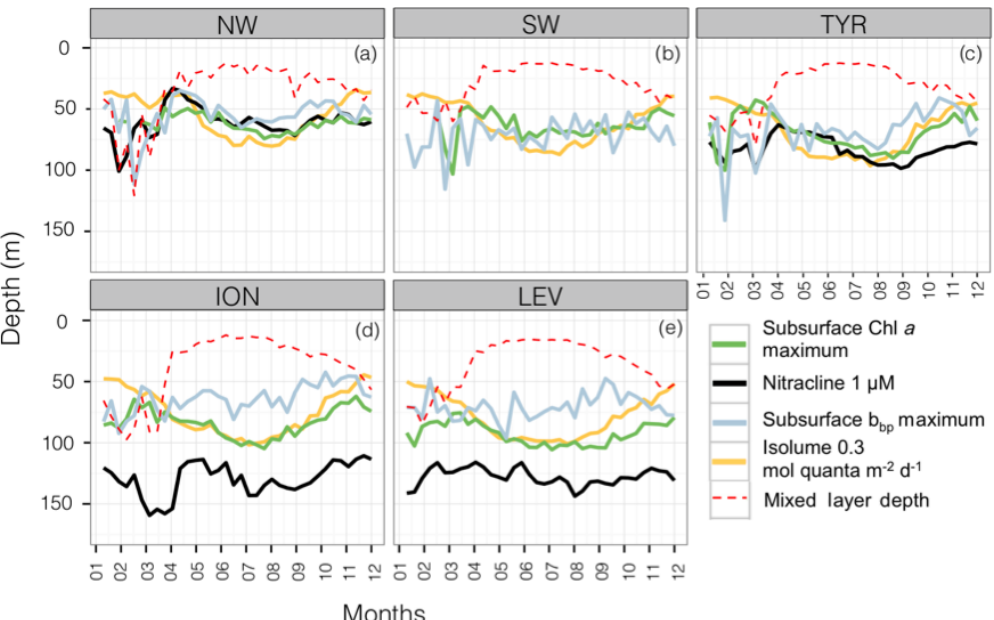
Figure 5. Monthly median values of the depths of the subsurface Chl a maximum (in green), the nitracline (in black), the subsurface b bp maximum (in blue), the reference isolume (in yellow) and the mixed layer (in dotted red) for the five Mediterranean regions. The depth of the nitracline is not shown for the SW as there is no BGC-Argo float equipped with a nitrate sensor for this